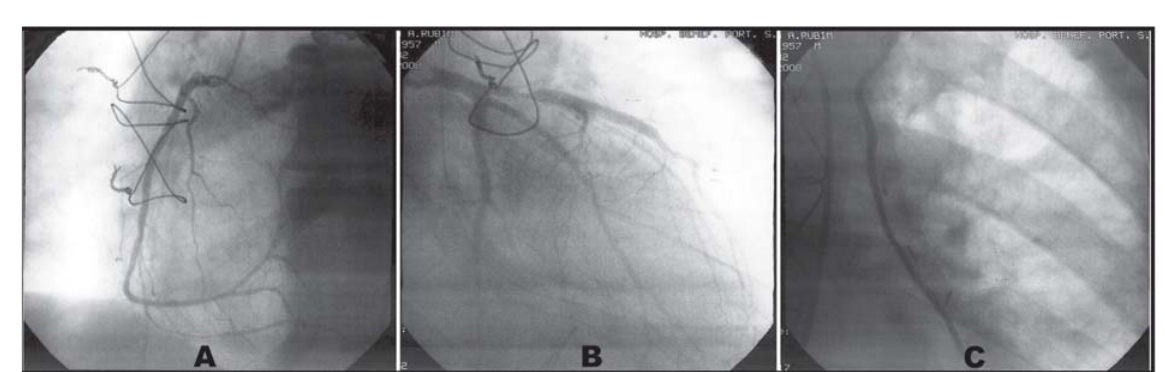
Fig. 5 - Angiografia das artérias coronária direita (A) , coronária esquerda (B) e anastomose entre ATIE e AIA (C) com restabelecimento dos calibres usuais das artérias coronárias e seus ramos após vasodilatador